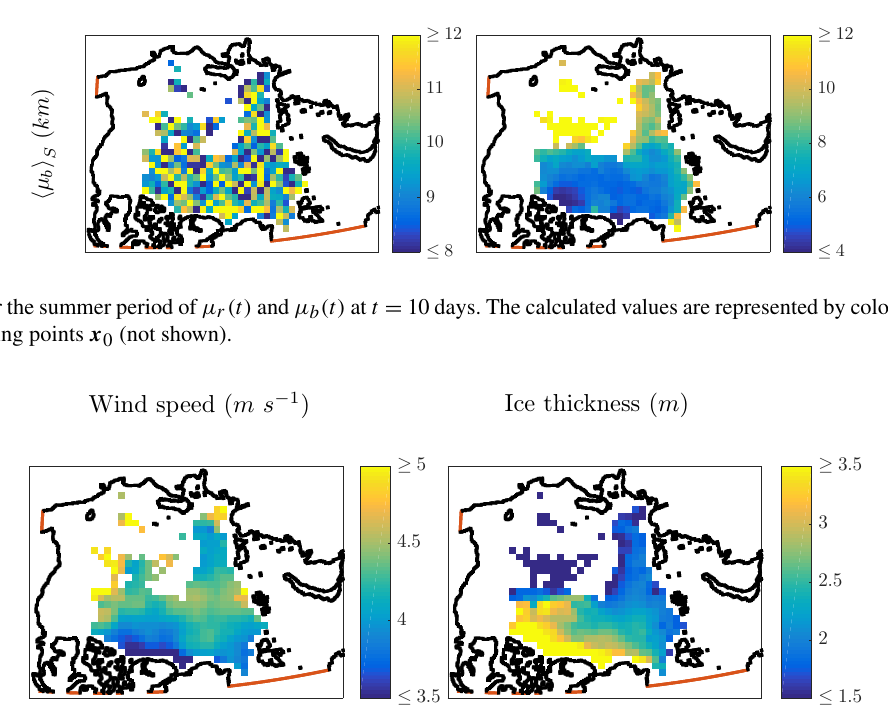
Figure 9. Summer average of wind speed and ice thickness. Both maps are from the neXtSIM simulations, but a similar thickness field and the exact same wind speed field are obtained for the FD